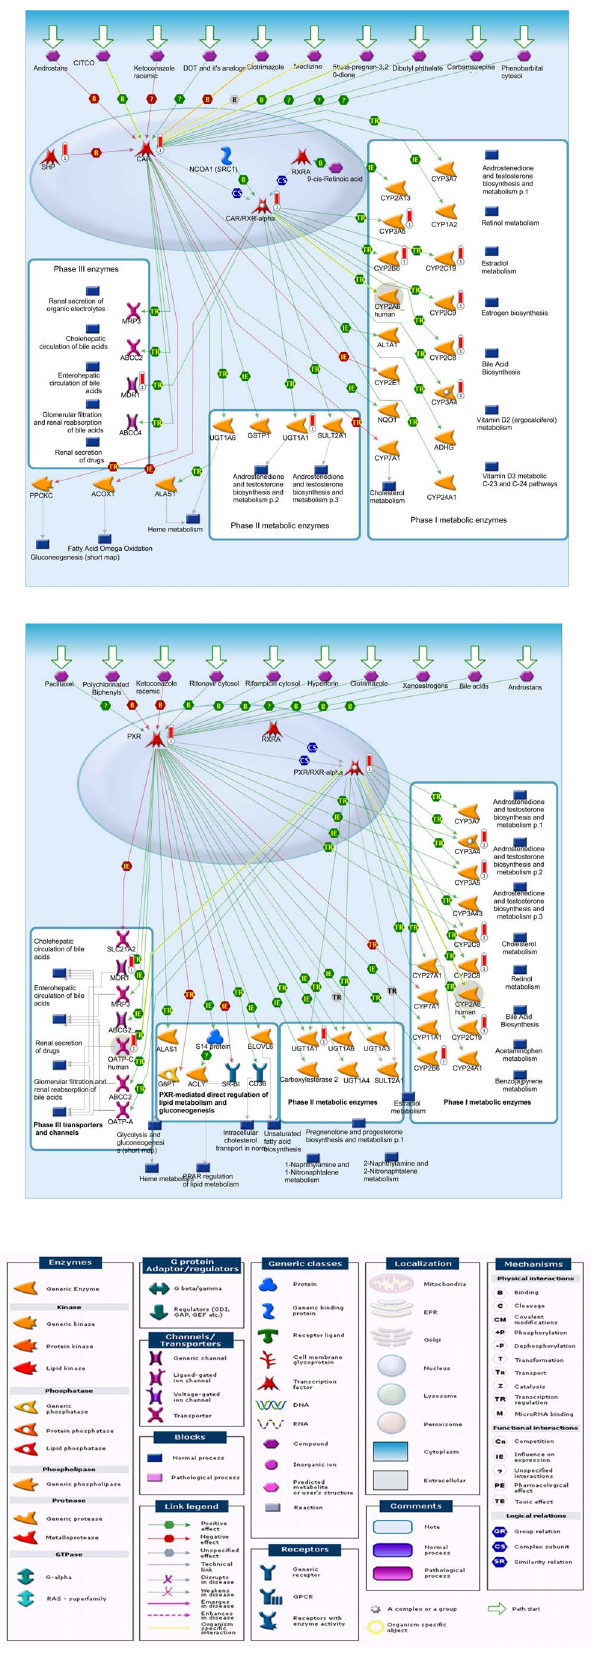
Figure 6. Regulation pathways for DMET expression by GeneGo analysis. The figure indicates the relationship among the ten most influential DMETs and drugs (Table 2), and the most common nuclear receptors (Table 3). The Panel A indicats the CAR/RXR mediated pathways in the regulation of DMET gene expression, and the Panel B indicates the PXR/RXR mediated pathways in the regulation of DMET gene expression. Panel C lists the legends to visualize the GeneGo pathway